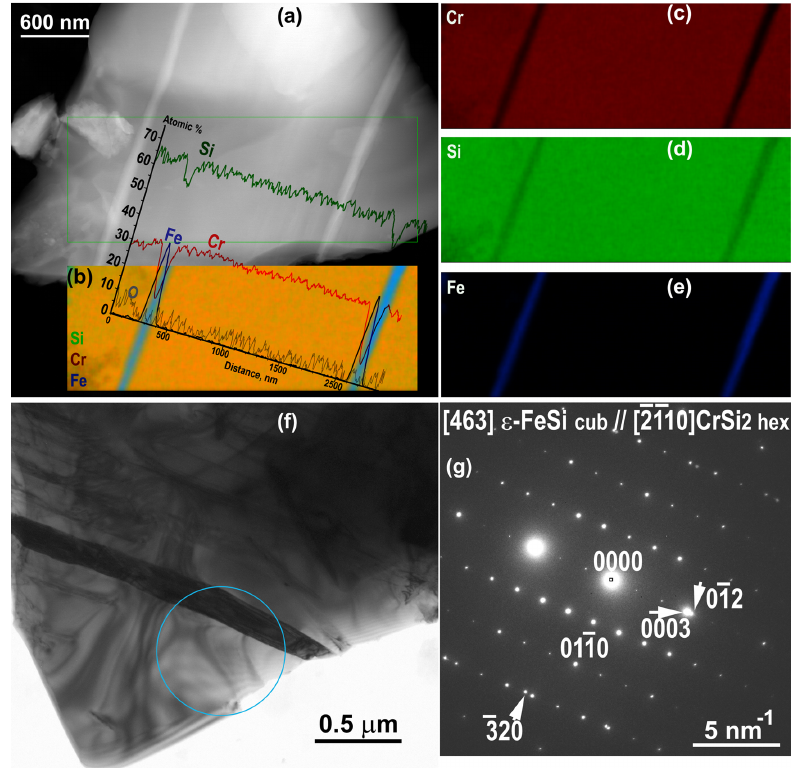
Figure 9. Annealed sample: HAADF STEM image ( a ) the EDXS map (in atomic %) and inserted concentration profiles from Cr, Si and Fe across the across the lamellar precipitate ( b ), EDXS elemental maps from Cr ( c ), Si ( d ) and Fe ( e ); TEM image ( f ) and the SAED pattern ( g ) corresponding to the circular area in ( f ) [463] (012) ε − FeSi cub and [2110] (0003) CrSi 2 hex are parallel.